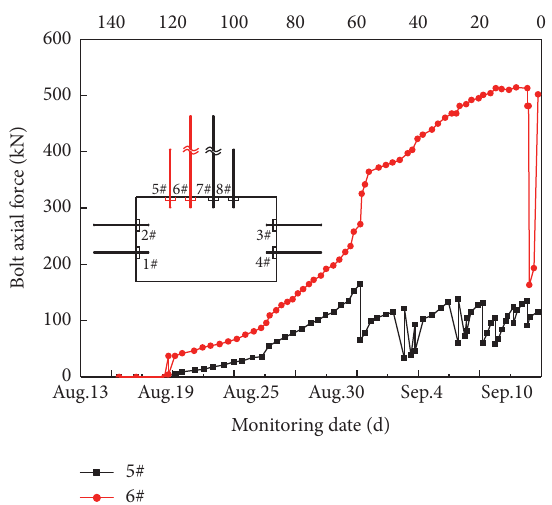
Figure 21: Hydraulic fracturing section: stress of the anchor cable at coal pillar side of 2# station.